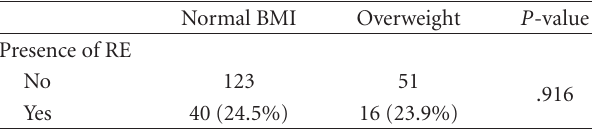
Table 2: Comparison between BMI group and presence of RE.